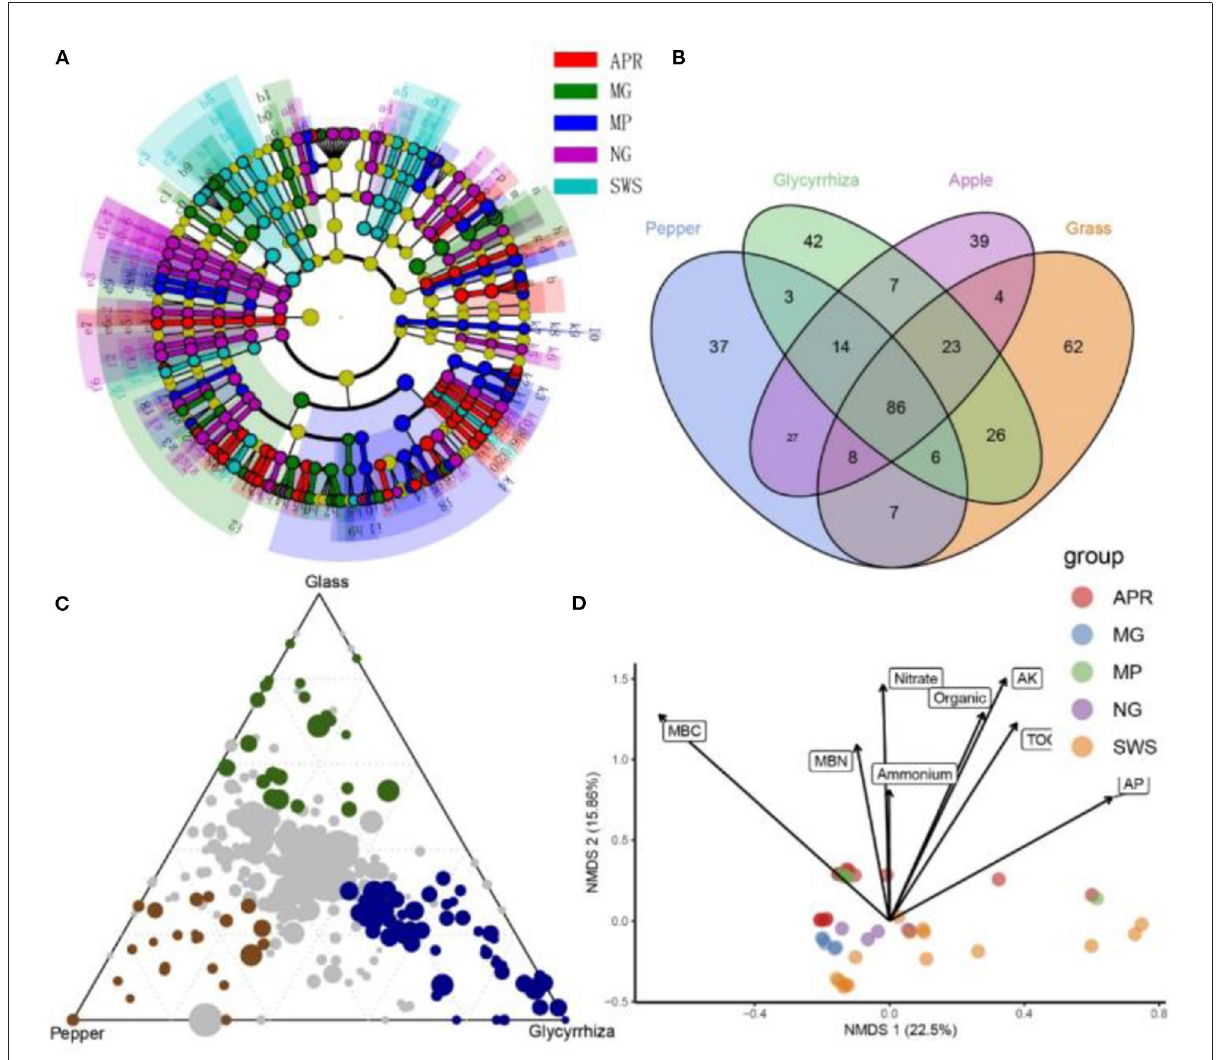
FIGURE2 Shared and significantly enriched microbial taxa among groups. (A) The linear discriminant analysis effect size (LefSe) plot presents the LDA effect size taxonomic cladogram of APR, MG, MP, NG, and SWS. Significantly discriminant microbial taxa are colored according to the highest-ranked group for that taxon. Indicator microbial taxa with LDA > 3.5, FD > 2, p < 0.05 in bacterial communities associated with different groups were presented in the graph. (B) Venn diagrams presenting the shared and specific OTUs in different root-soil samples, including root soil of apple, root-soil of grass, root-soil of glycyrrhiza, and root-soil of pepper. (C) The ternary plot presents significantly enriched bacterial OTUs in natural grass (green filled circles), pepper (brown filled circles), and licorice (blue filled circles). The gray dots in the center of the ternary graph represent non-significant bacterial OTUs shared by all groups. (D) The redundancy analysis (RDA) ordination of significant soil properties in root-soil samples and SWS samples. Vectors show fitted values of soil factors significantly correlated within ordination space. The correlations between the soil factors and RDA axes are represented by the length and angle of the